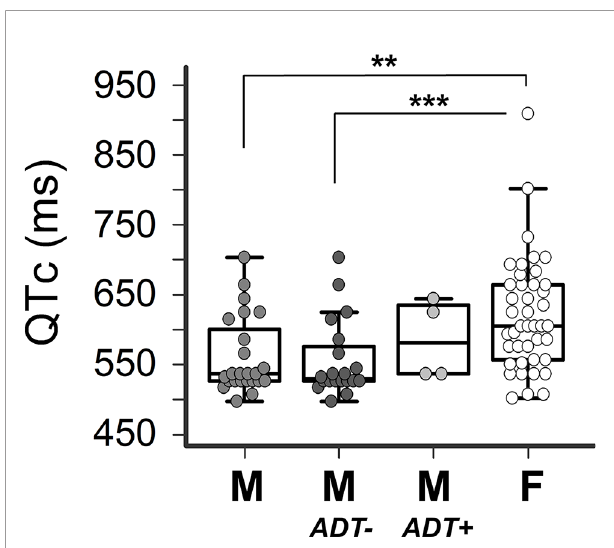
FIGURE 1 | Impact of sex and androgen deprivation therapy on QTc in TdP patients. Comparisons of QTc in males (M, n=24), males untreated with androgen deprivation therapy (M-ADT-, n=20), males treated with androgen deprivation therapy (M-ADT+, n=4), and females (F, n=42). ***p < 0.001, **p < 0.01; M-ADT+ vs F: p=0.38; M-ADT- vs M-ADT+: p=0.14. All comparisons were performed by the two-tails Mann-Whitney test: QTc: heart-rate corrected QT interval; TdP: Torsades de